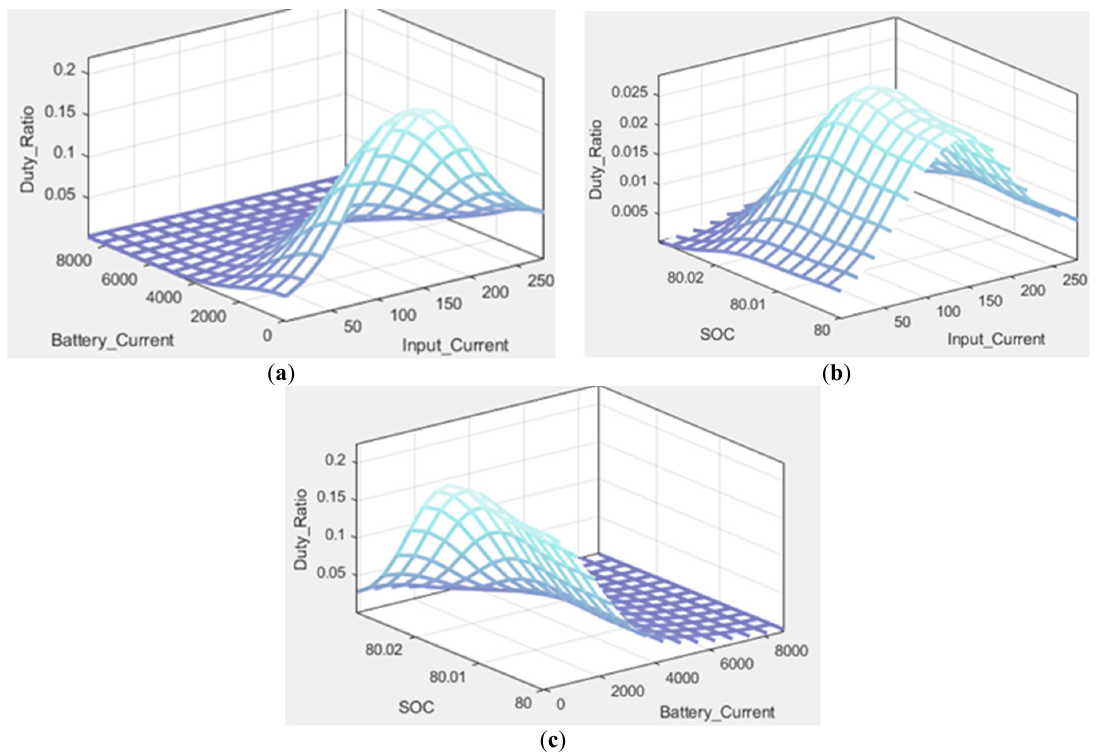
Figure 37. Surface representation for the variables ( a ) battery current, input current and duty ratio, ( b ) SOC, input current and duty ratio ( c ) SOC, battery current and duty ratio.